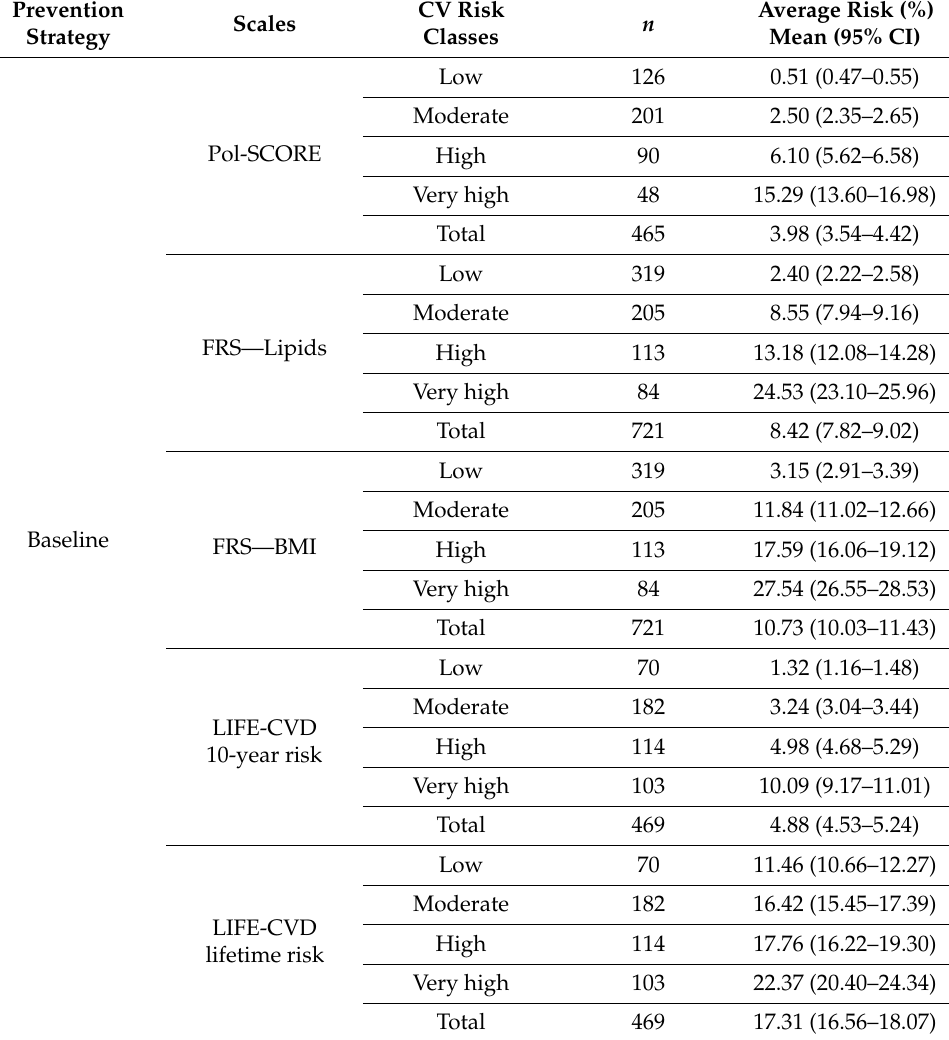
Table 2. Prediction of 10-year risk of fatal CVD (Pol-SCORE), 10-year risk of developing first CVD event (Framingham Cardiovascular Disease), and 10-year risk or life risk of MI, stroke, or CV death (lifetime-perspective model for individualizing cardiovascular disease prevention strategies in apparently healthy people: